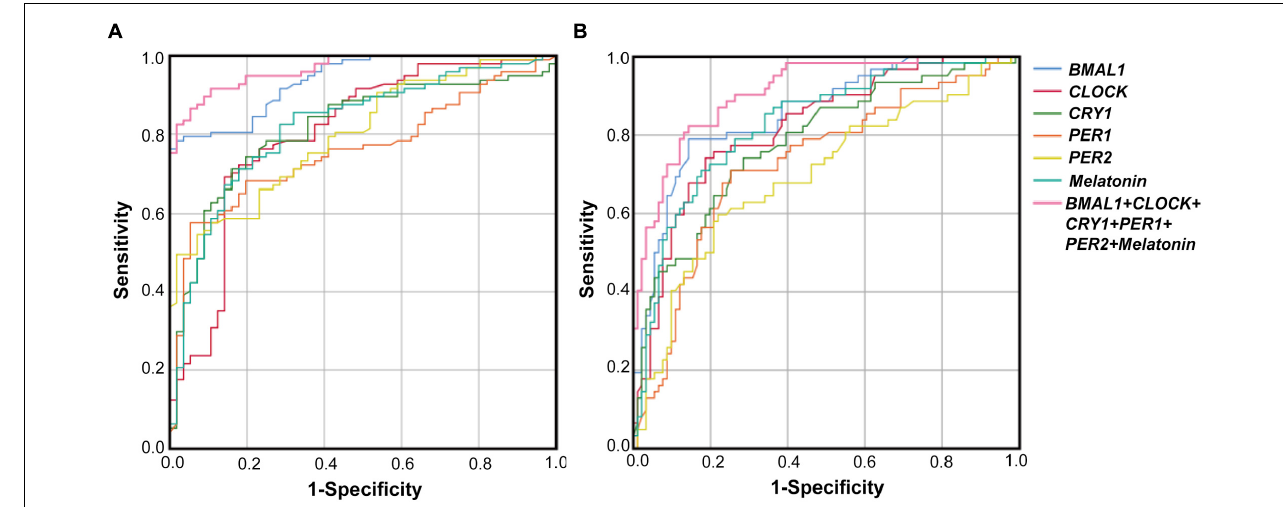
FIGURE 4 | Receiver operating characteristic (ROC) curves of BMAL1 , CLOCK , CRY1 , PER1 , PER2 and melatonin levels for PD with pRBD vs. PD without pRBD, and those for PD with EDS vs. PD without EDS. (A) The AUCs values of BMAL1 , CLOCK , CRY1 , PER1 , PER2 , melatonin, and the combination of five clock genes and melatonin for pRBD were 0.94 ( BMAL1 , 95% CI, 0.9–0.97, P < 0.05), 0.8 ( CLOCK , 95% CI, 0.73–0.88, P < 0.05), 0.81 ( CRY1 , 95% CI, 0.74–0.88, P < 0.05), 0.76 ( PER1 , 95% CI, 0.68–0.84, P < 0.05), 0.8 ( PER2 , 95% CI, 0.73–0.87, P < 0.05), 0.82 (melatonin 95% CI, 0.75–0.89, P < 0.05), and 0.97 (combined five clock genes and melatonin, 95% CI, 0.94–0.99, P < 0.05), respectively. (B) The AUCs values for EDS were 0.86 ( BMAL1 , 95% CI, 0.8–0.92, P < 0.05), 0.82 ( CLOCK , 95% CI, 0.75–0.89, P < 0.05), 0.78 ( CRY1 , 95% CI, 0.71–0.86, P < 0.05), 0.73 ( PER1 , 95% CI, 0.65–0.81, P < 0.05), 0.7 ( PER2 , 95% CI, 0.61–0.78, P < 0.05), 0.83 (melatonin, 95% CI, 0.76–0.9, P < 0.05), and 0.91 (combined five clock genes and melatonin, 95% CI, 0.86–0.96, P < 0.05),